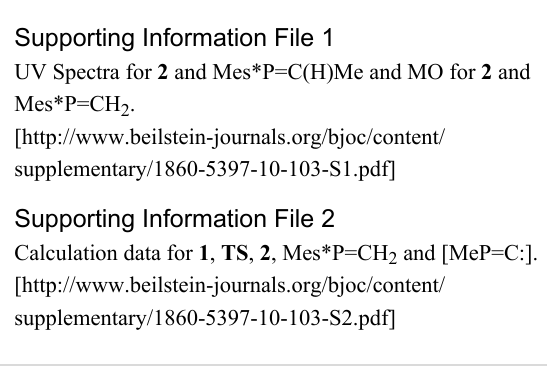
requires an activation energy, whereas the phosphorus version of the FBW rearrangement proceeded without an energetic barrier. The optimized structure of 2 indicates the possible conjugation between the P=C π -system and aromatic substituent, which induces remarkably different physicochem- ical properties for the Mes*-substituted phosphaalkenes, where the P=C moiety is almost perpendicular to the aromatic